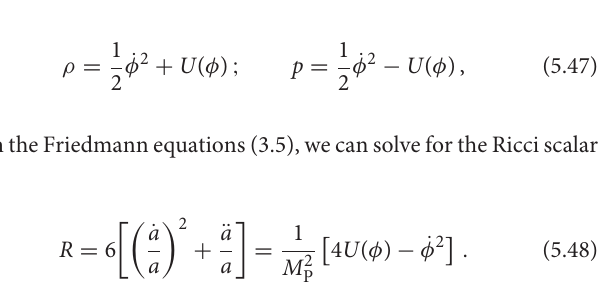
Vaskonen (2016), Dimopoulos and Markkanen (2018), and Haro